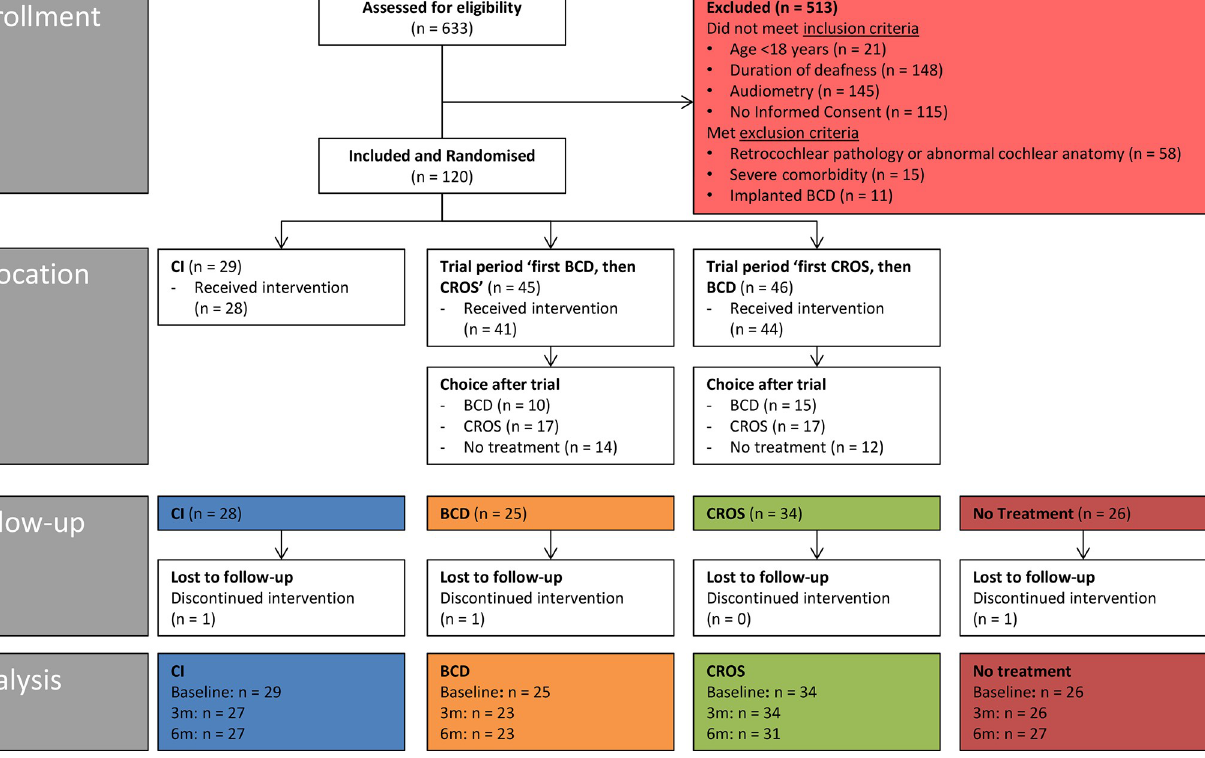
PLOS ONE | https://doi.org/10.1371/journal.pone.0257447 October 13,